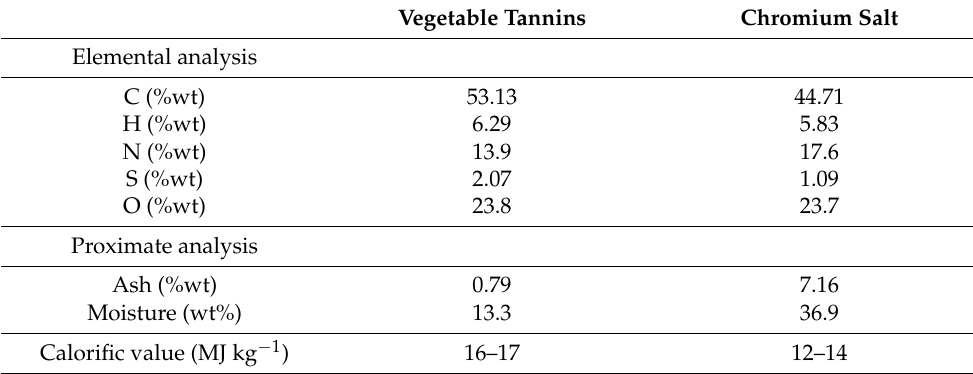
Table 1. Chemical characterisation of the raw material.